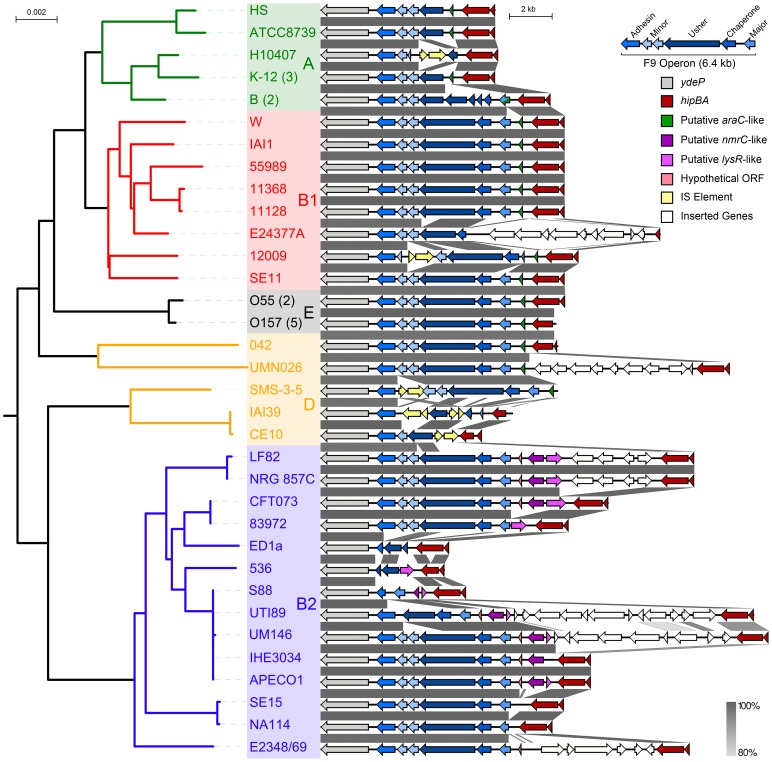
Conservation and genetic organisation of the E. coli f9 fimbrial operon in an evolutionary context.Left: The phylogeny of 42 E. coli strains is displayed as inferred by the Neighbour-Joining method on the concatenated nucleotide sequence of 7 housekeeping genes (9,015 nt over an equal number of positions). E. coli strains are colour-coded according to phylogroup (A, B1, B2, D and E). The scale on the phylogenetic tree represents the number of nucleotide substitutions per site. Closely related strains with identical f9 genetic context are collapsed and included E. coli K-12 (n = 3; strains MG1655, DH10β, BW2952), E. coli B (n = 2; strains BL21(DE3), B REL606), E. coli O55 (n = 2; strains CB9615, RM12579), E. coli O157 (n = 5; strains EDL933, Sakai, EC4115, TW14359, Xuzhou21). Right: Alignment of the f9 genes (blue) and their flanking genes. The f9 operon is flanked 3′ by the highly conserved ydeP gene (grey) and 5′ by the hipBA operon (red). The direct 5′ region of the f9 operon is variable, and involves three distinct hypothetical transcriptional regulators (green, purple, and lilac). The percentage DNA sequence identity is indicated in grey. The scale on the aligned genetic context represents DNA length in kilobase pair.